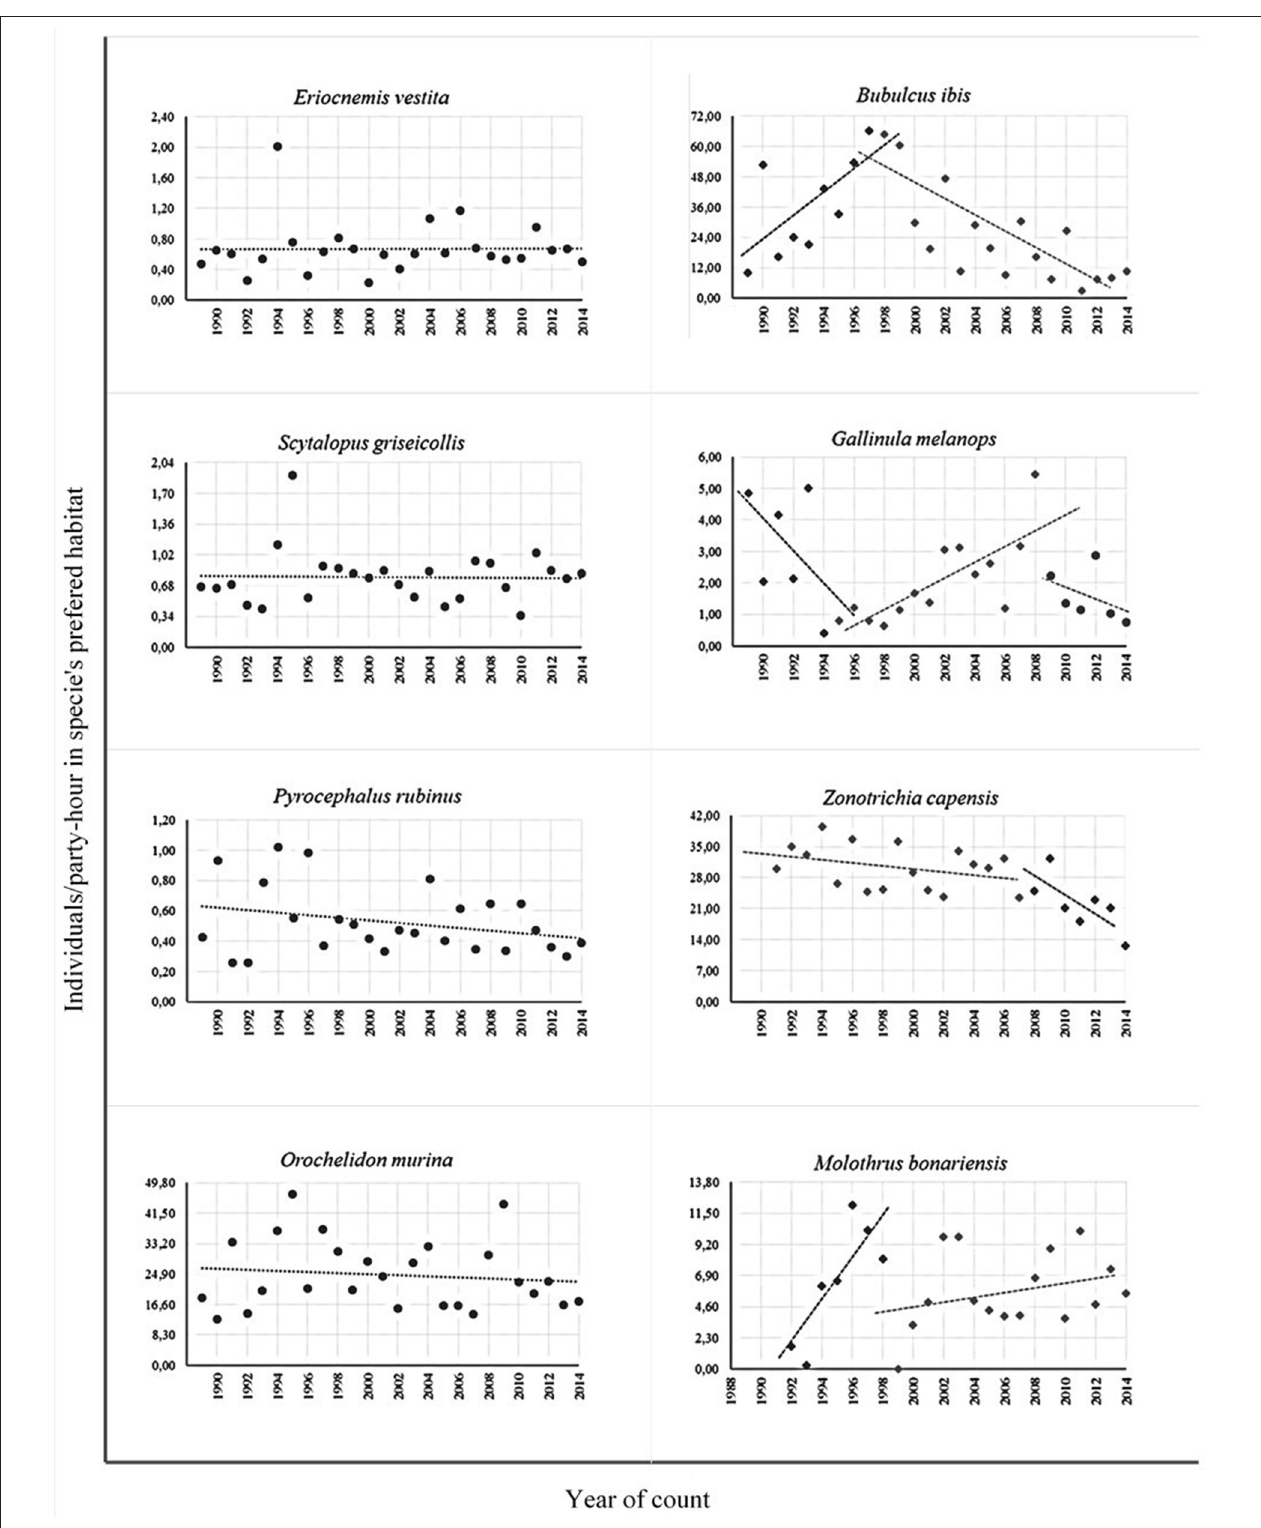
FIGURE 8 | Examples of bird species that were stable or had complex tendencies in which the direction of change varied along the period between 1989 and 2014 in the Sabana de Bogotá Audubon’s Christmas Bird Count circle.